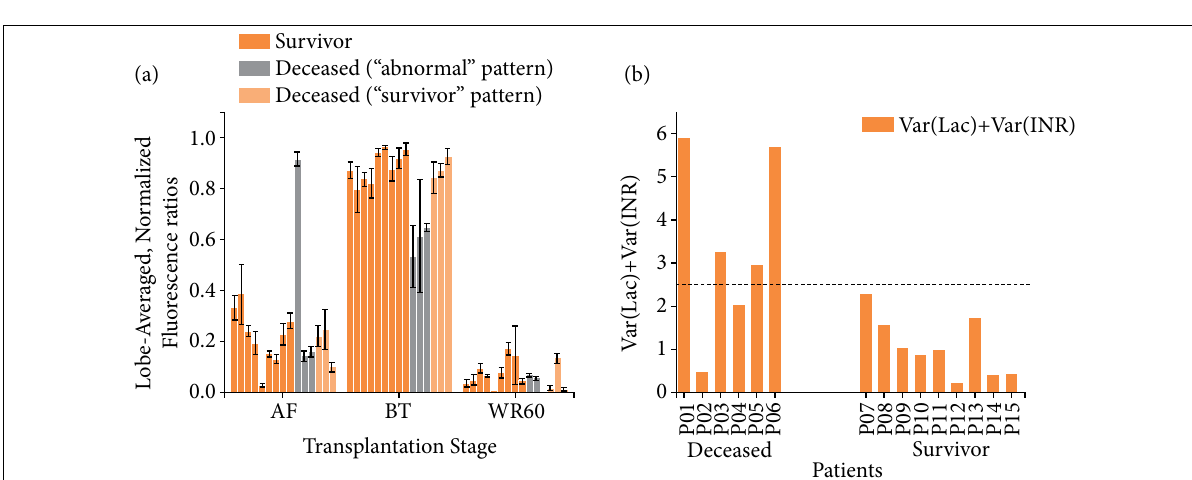
Figure 4 - Average fluorescence ratios and relevant biochemical variations for surviving-versus-deceased patients. (a) Averages per patient of the RBEM of fluorescence, according to the transplantation stage; these averages show that three of the six cases of unsuccessful transplantation procedures show a deviant behavior of the RBEM, which indicates a distortion of the spectra during the process; (b) The joint variation of lactate and prothrombin per patient is shown. The relative variation indexes of lactate (Lac) associated with prothrombin (INR) were used for assessment. About 67% of deceased patients showed simultaneously high values of relative Lac and INR. When the relative variation indexes are summed up, these values reached over 2.5 for most deceased patients, in contrast to all surviving patients, suggesting a correlation between death and alterations undergone by the transplanted liver